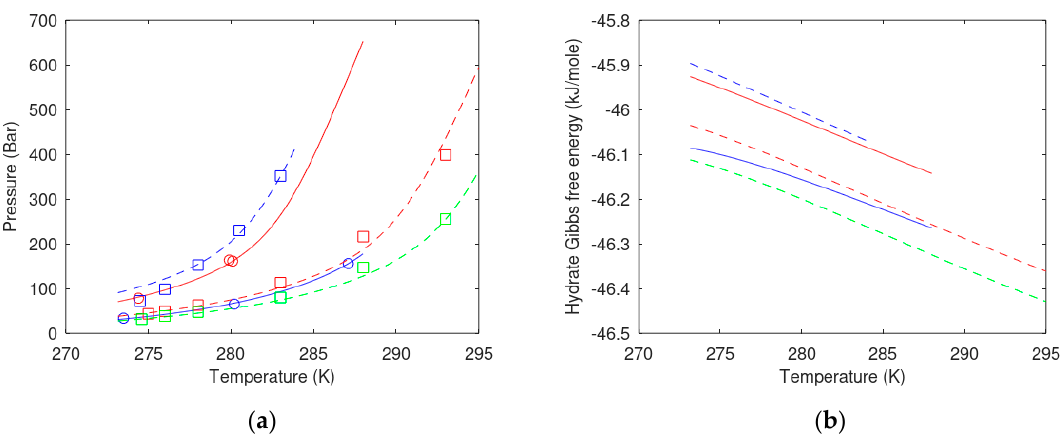
Figure 1. ( a ) Temperature pressure stability limits for CH 4 hydrate formed from CH4 and water containing MEG (circles are experimental data [38] and solid curves are calculated) or TEG (squares are experimental data [39] and dashed curves are calculated). Blue curves and circles are for 10 wt% MEG in water. Red circles and curve are for 30 wt% MEG. Green squares and dashed curve are for 10 wt% TEG. Red squares and dashed curve are for 20 wt% TEG and blue squares and dashed curve are for 40 wt% TEG. ( b ) Gibbs free energy for hydrates formed along the stability curves in Figure 1a. Same line notations as in Figure 1a.